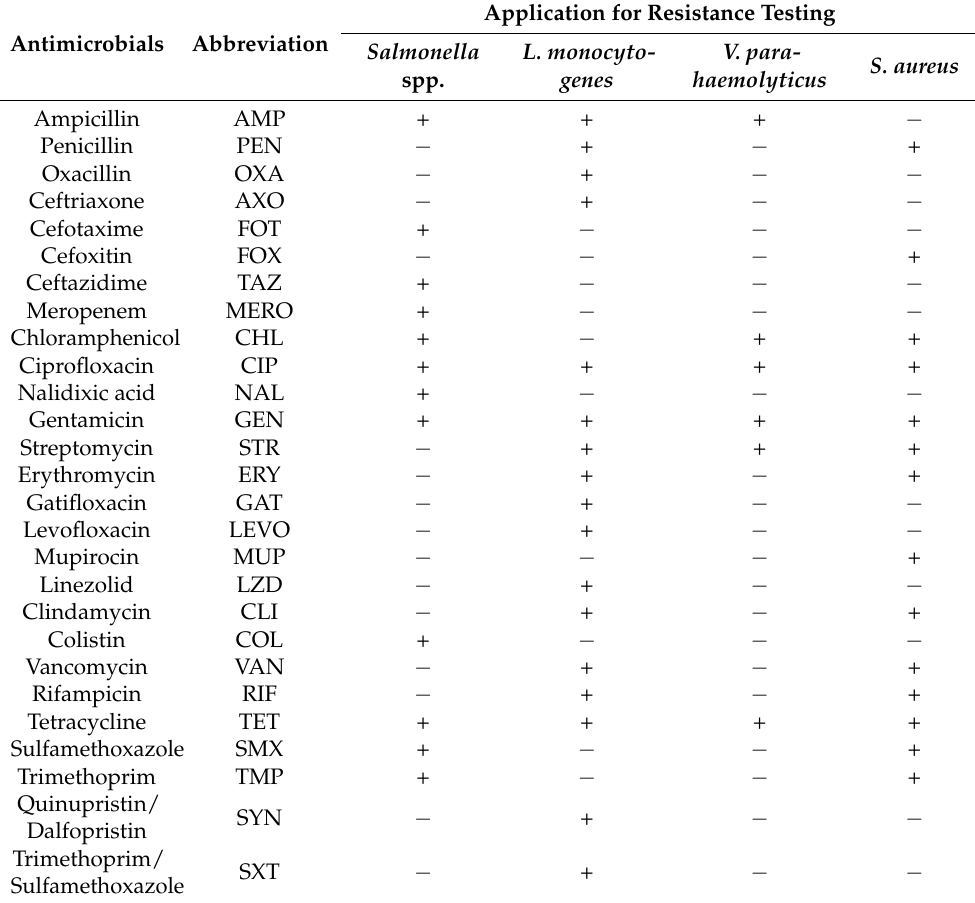
Table 2. Antimicrobials used for the determination of resistance of the tested bacteria.